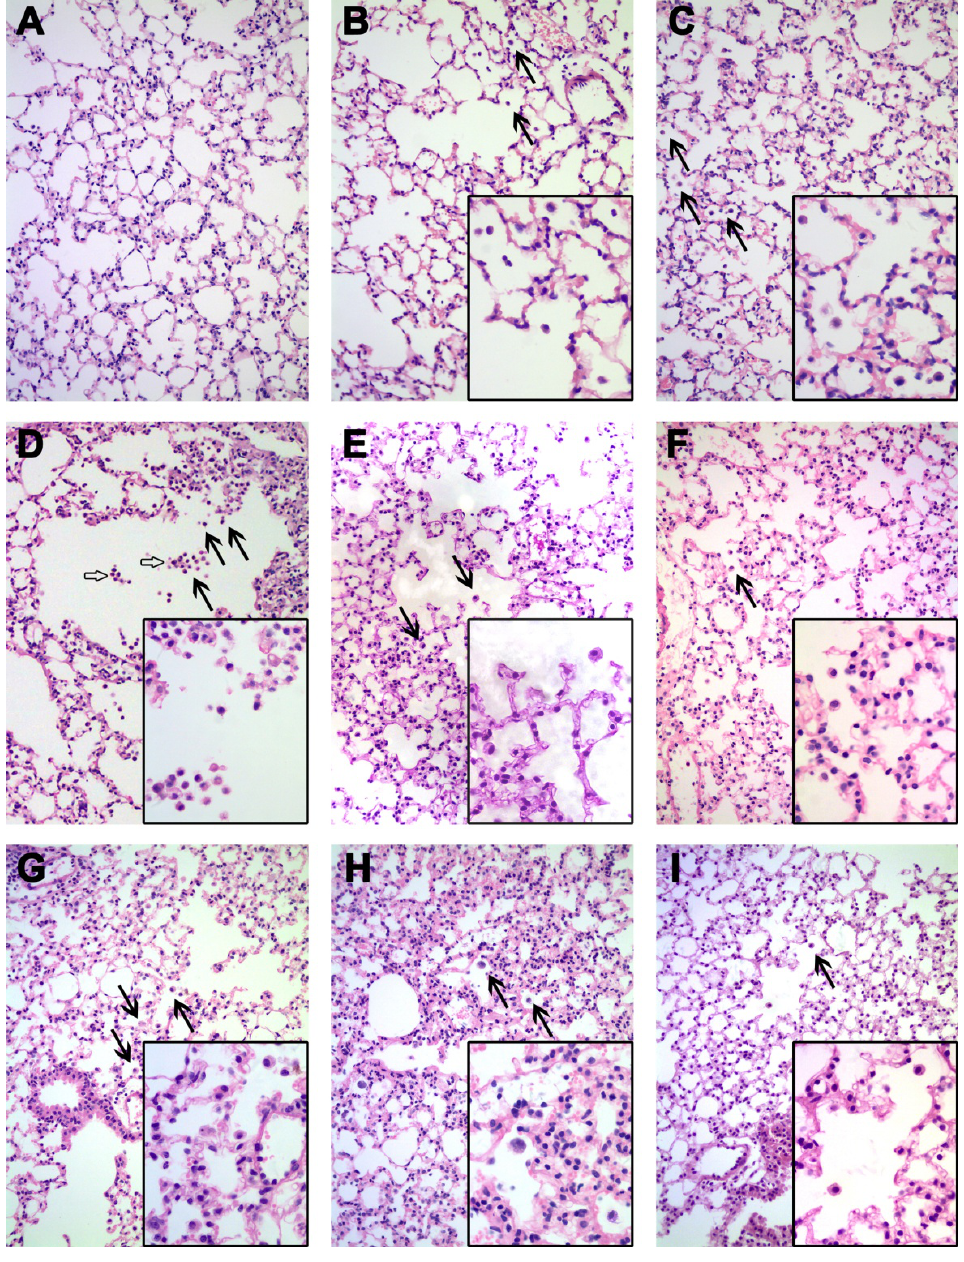
Figure 5. Light micrographs of hematoxylin-eosin stained lung tissue slices after intratracheal instillation of Ceria-p and Ceria-h. ( A ) The lung of mice from the control; ( B – E ) the lung of mice exposed to Ceria-p at 1, 3, 7 and 28 days post-instillation (PI), respectively; ( F – I ) the lung of mice exposed to CeO -h at 1, 3, 7 and 28 days PI; 2 magnification: original ×200, inset ×400; solid arrow: particle-laden macrophages; hollow arrow: